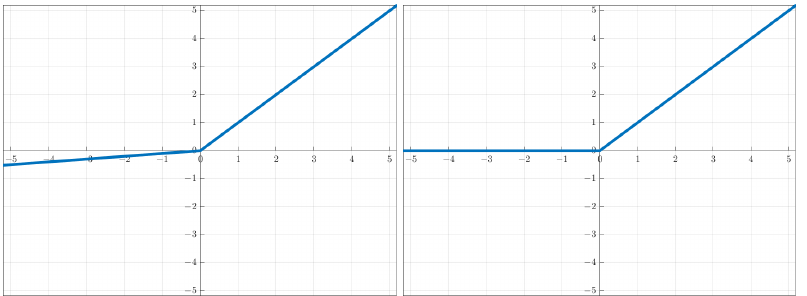
Figure 1. This work focuses on two-layer neural networks (NNs) with ReLU (rectified linear unit)and ReLU-like activation functions σ ( x ) = α x + ( 1 − α ) max ( 0, x ) , with α ∈ [ 0,1 ) . Shown are the leaky ReLU ( α = 0.1, left ) and the ReLU ( α = 0, right ).